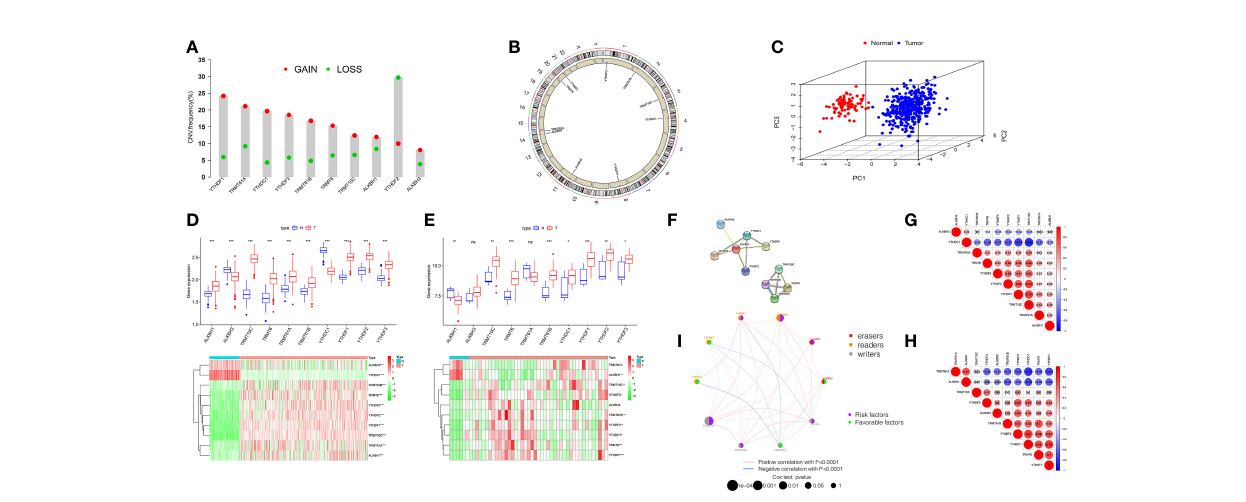
FIGURE 1 | Landscape of genetic and expression variation of m1A regulators in ovarian cancer. (A) The CNV variation frequency of m1A regulators in TCGA-OV cohort. The deletion frequency, green dot; The ampli fi cation frequency, red dot. (B) The location of CNV alteration of m1A regulators on 23 chromosomes using TCGA cohort. (C) Principal component analysis for the expression pro fi les of 10 m1A regulators to distinguish tumors from normal samples in TCGA cohort. (D, E) Boxplot and differential expression heatmap of m1A RNA methylation regulators in OC and normal tissues from (D) TCGA and (E) GEO datasets. (F) The PPI network of m1A RNA methylation regulators. (G) Spearman correlation analysis of m1A RNA methylation regulators in TCGA cohort. (H) Spearman correlation analysis of m1A RNA methylation regulators in GSE27651 cohort. (I) The interaction among m1A regulators in ovarian cancer. Violet dots in the circle, risk factors of prognosis; green dots in the circle, favorable factors of prognosis. The lines linking regulators showed their interactions, and thickness showed the correlation strength between regulators. *P < 0.05; **P < 0.01; ***P < 0.001. ns, not signi fi